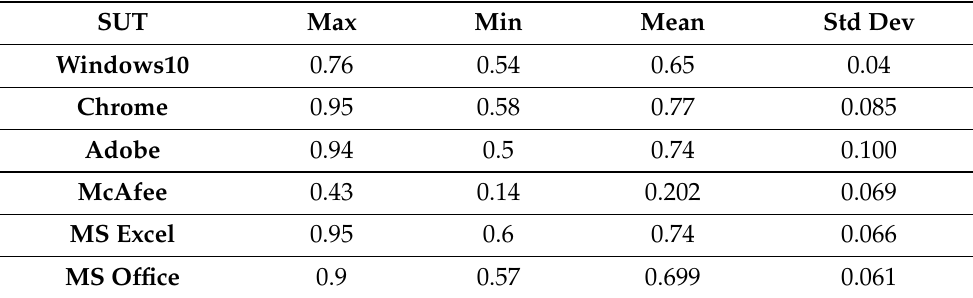
Table 2. Statistical analysis of maximum fitness scores of 100 configurations collected after 100 runs of RL script executed on different